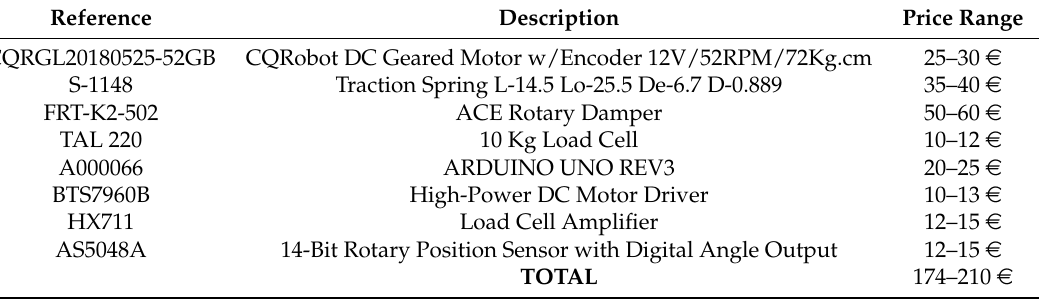
Table 1. Components used and their price